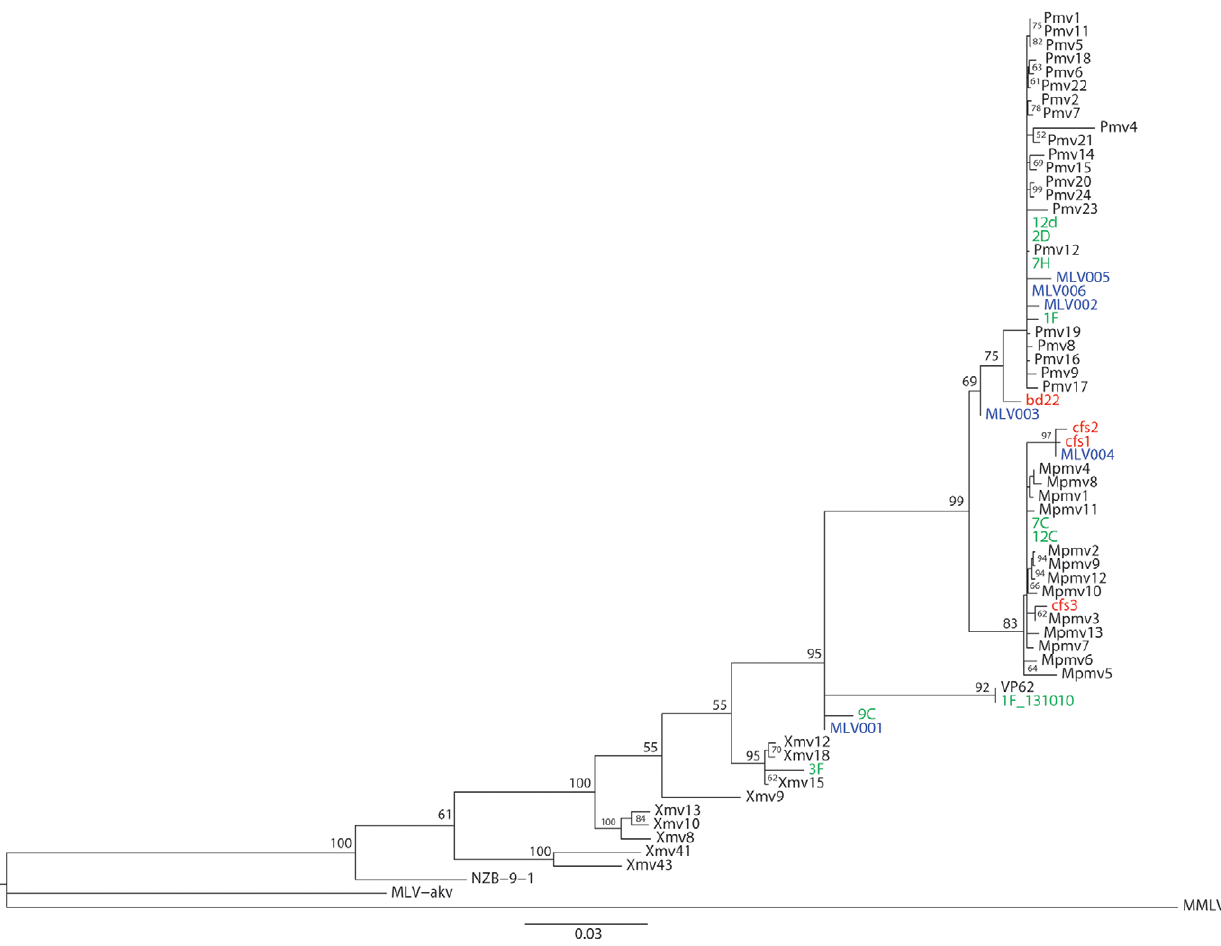
Figure 2. Maximum likelihood tree of gag sequences. The MLV RAxML tree for gag sequences lying between XMRV primers gagIF and gagIR was developed from the endogenous MLV sequences identified by Jern et al [19], sequences derived from CFS patients by Lo et al [5] (shown in red and blue) and the sequences amplified in this study (in green). In addition to sequences from the RNA and DNA, ‘‘1F_131010’’ and ‘‘1F’’ are included. 1F_131010 was derived from the amplification of cDNA synthesized from RNA extracted from the tissue culture fluid supernatant of an XMRV culture, kindly provided by Professor M McClure. 1F was derived from the amplification of Balb/c mouse DNA (Sigma). Bootstrap values . 50 are indicated.